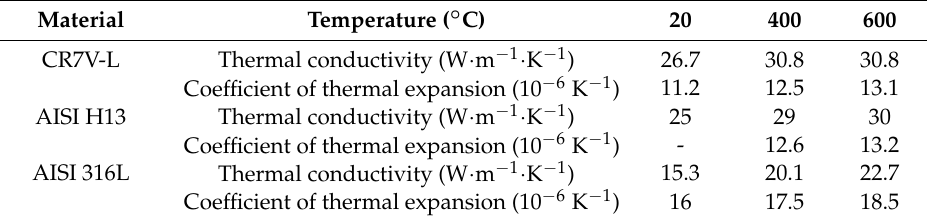
Table 2. Thermal properties of the used materials, data from